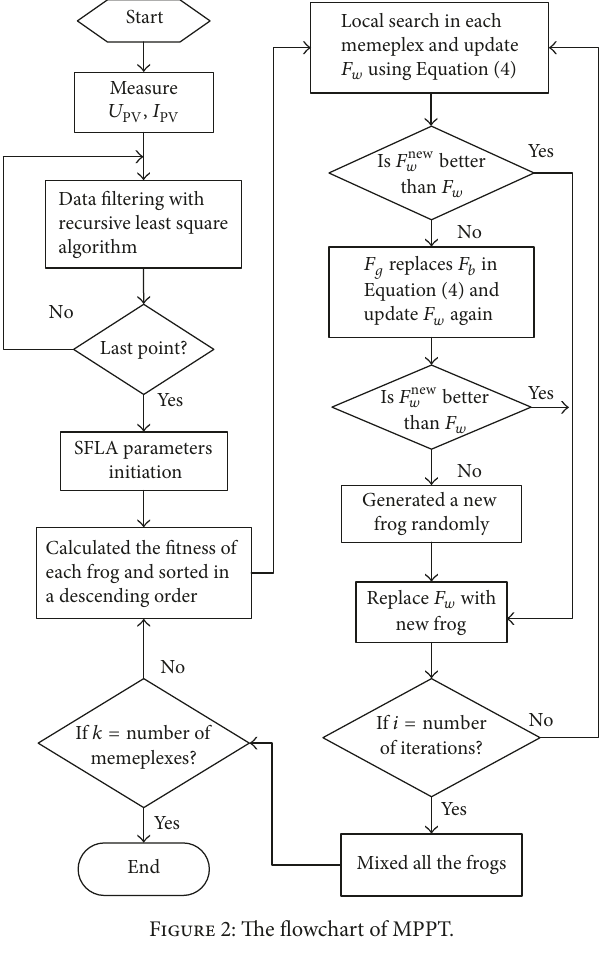
Figure 2: The flowchart of MPPT.